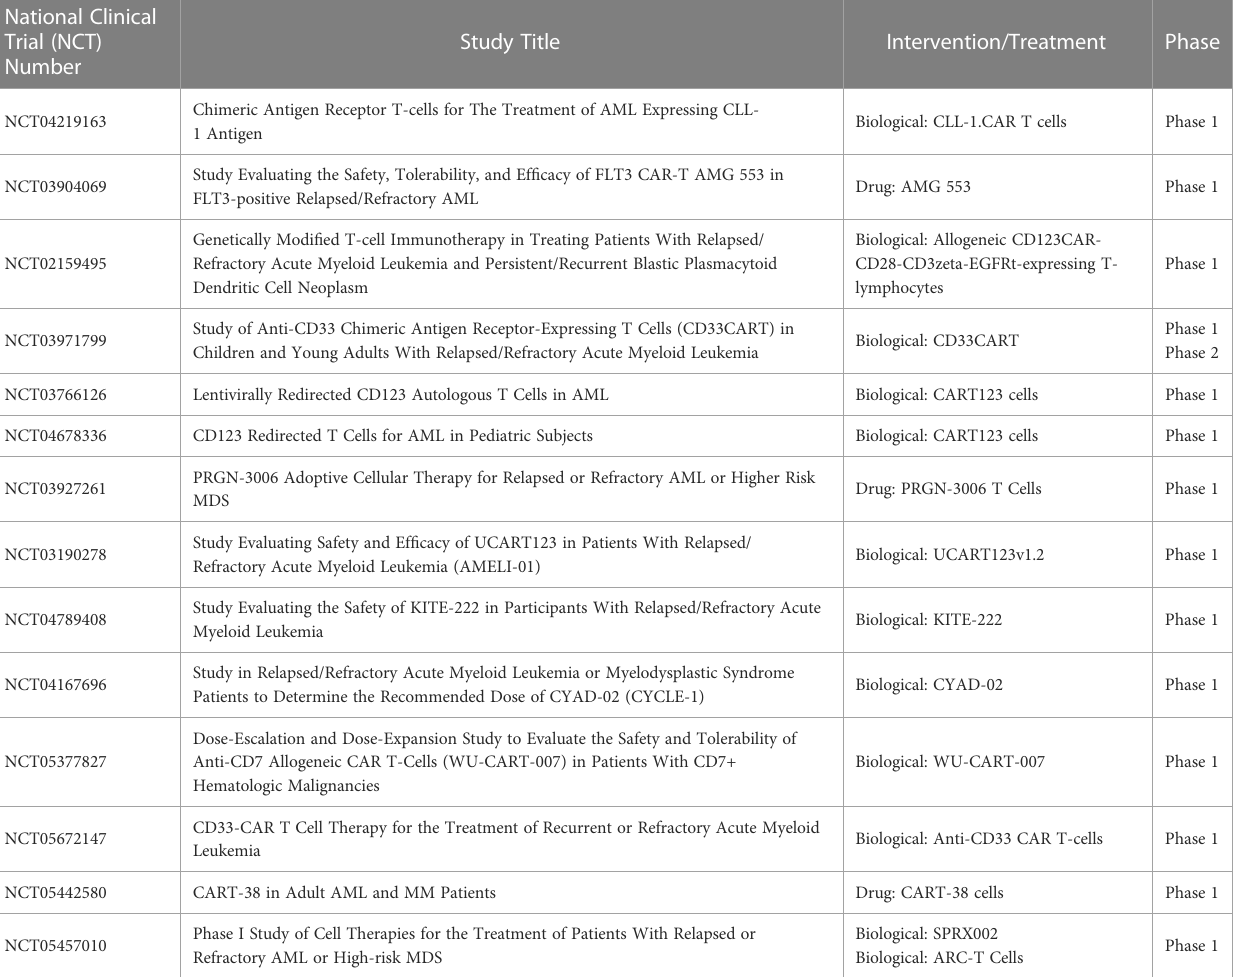
TABLE 3 Ongoing CAR-T therapy clinical trials in the United States for the treatment of relapsed or refractory acute myeloid